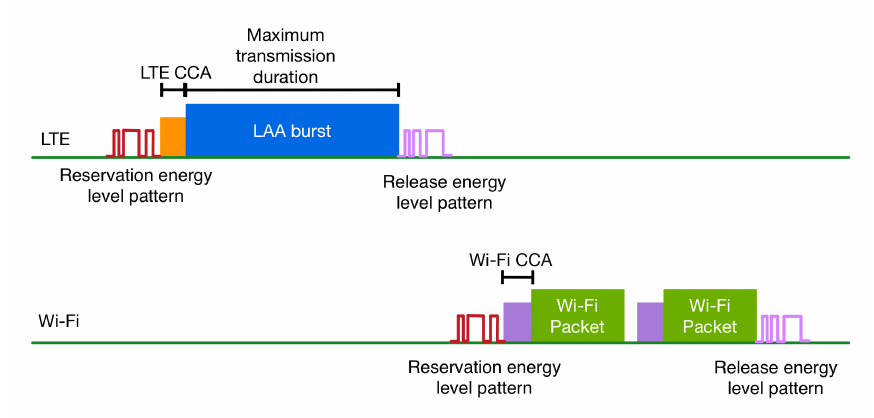
Figure 11. Inter-Radio Access Technology (RAT)